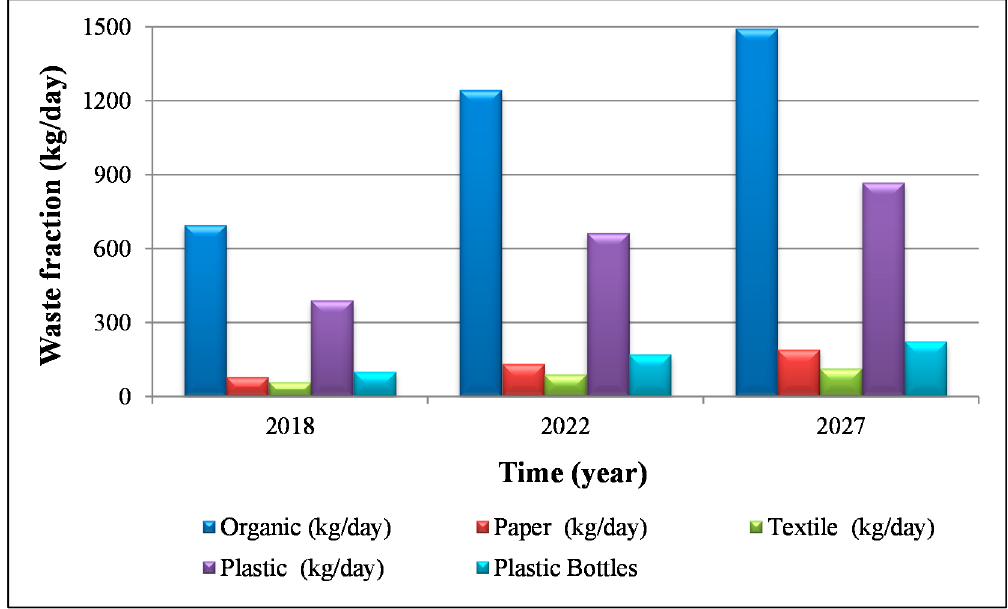
Figure 5. Quantity of each fraction currently generated on the campus, and time horizons 2022 and 2027.